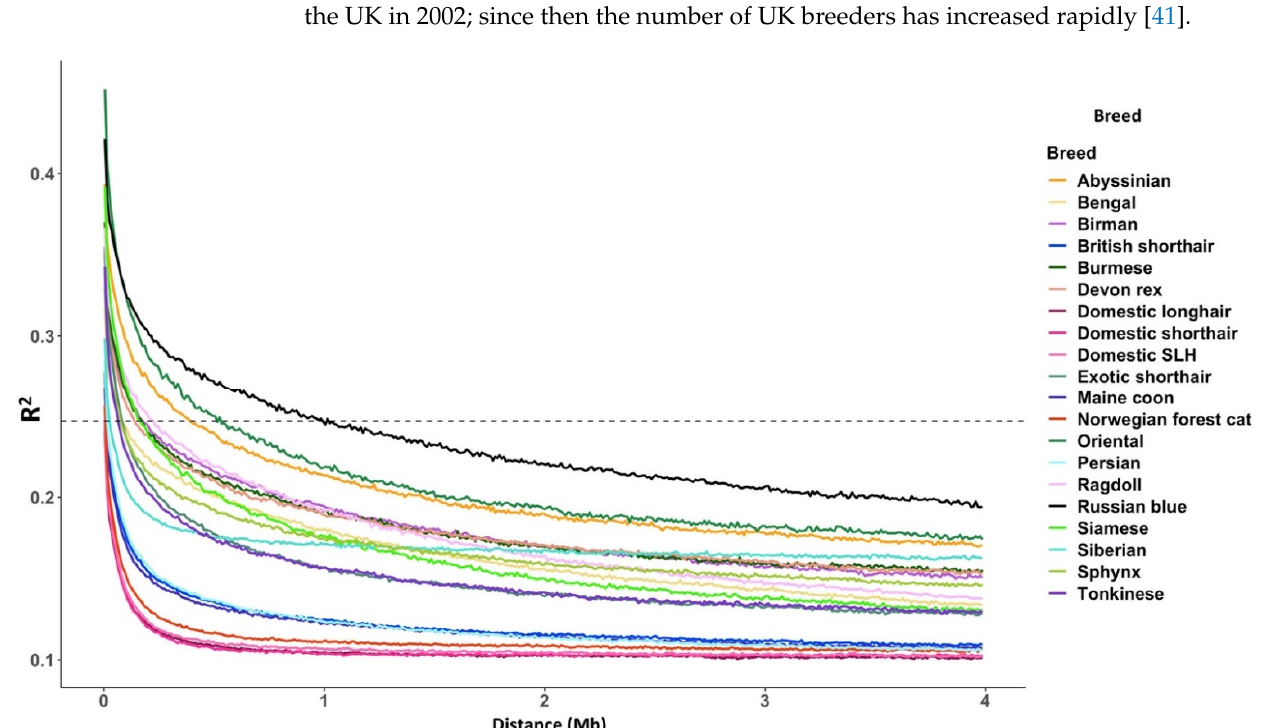
Figure 4. The genome wide rate of linkage disequilibrium decay. The dashed line marks R 2 = 0.247 the maximum R squared in the random-bred population.